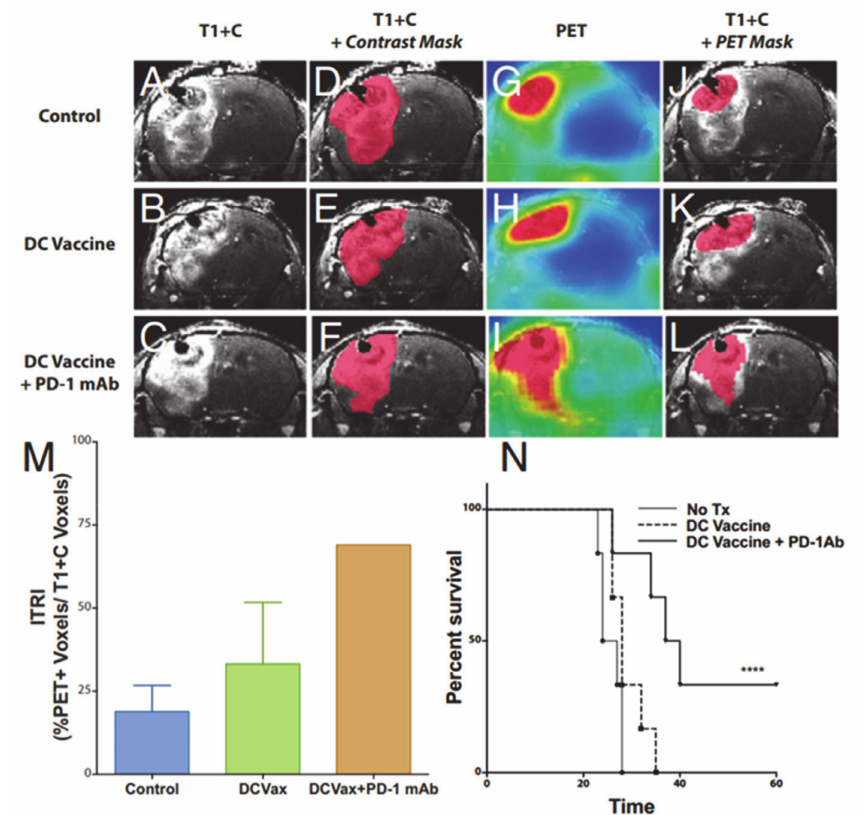
Figure 9. Representative coronal post-contrast T1 weighted images of untreated control, dendritic cell vaccination (DCVax; Northwest Biotherapeutics)-treated, and DCVax + PD-1 mAb-treated GBM bearing mice ( A – C ). Representative contrast subtraction maps (red; contrast mask) overlaid onto post- contrast T1 weighted images ( D – F ). Representative coronal [ 18 F]-FAC PET images of untreated control and DCVax- and DCVax + PD1 mAb-treated mice ( G – I ). Representative threshold PET subtraction maps (red; PET mask) overlaid onto post-contrast T1 weighted images ( J – L ). The immunotherapeutic response index (ITRI, a ratio of the PET voxels divided by the T1+C subtraction voxel data) calculated for each treatment group is shown ( M ). Increased ITRI values were observed in mice treated with DCVax and/or PD-1 mAb compared with untreated mice. Survival plots of intracranial GBM-bearing untreated control (no Tx), DCVax-treated, and DCVax + PD-1 mAb-treated mice ( N ). Reprinted with permission from ref.